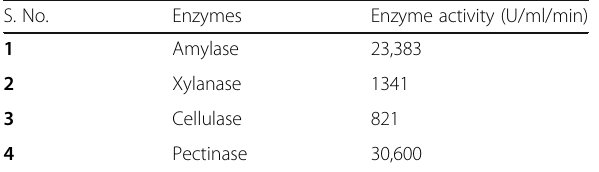
Table 2 Screening of date fruit wastes for the production of pectinase, xylanase, cellulase, and amylase by Bacillus licheniformis KIBGE-IB3 S. No.